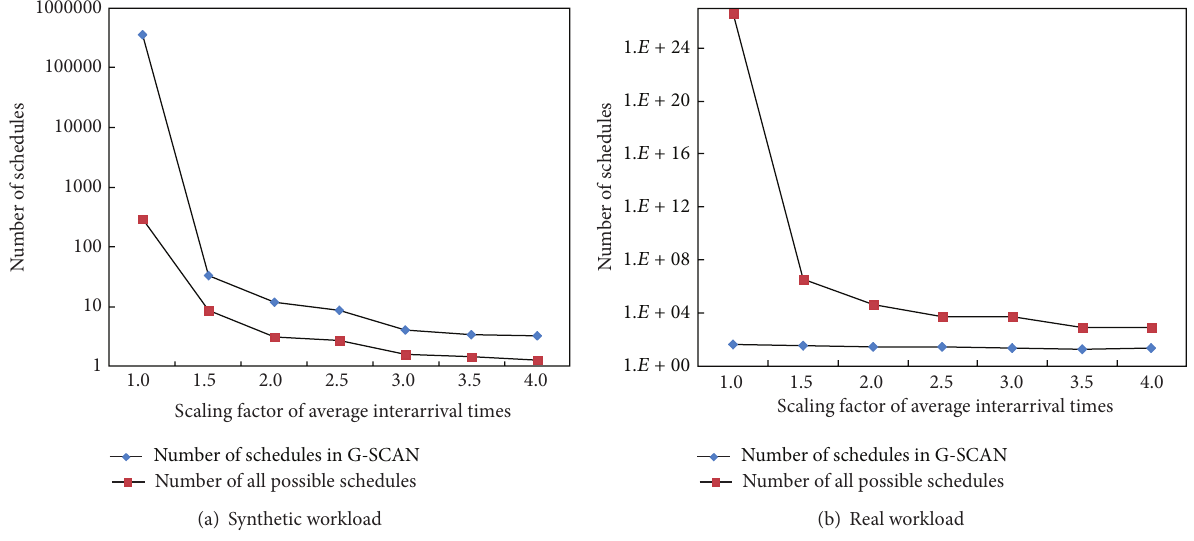
Figure 10: Comparison of G-SCAN and complete searching mechanism as a function of the scaling factor.